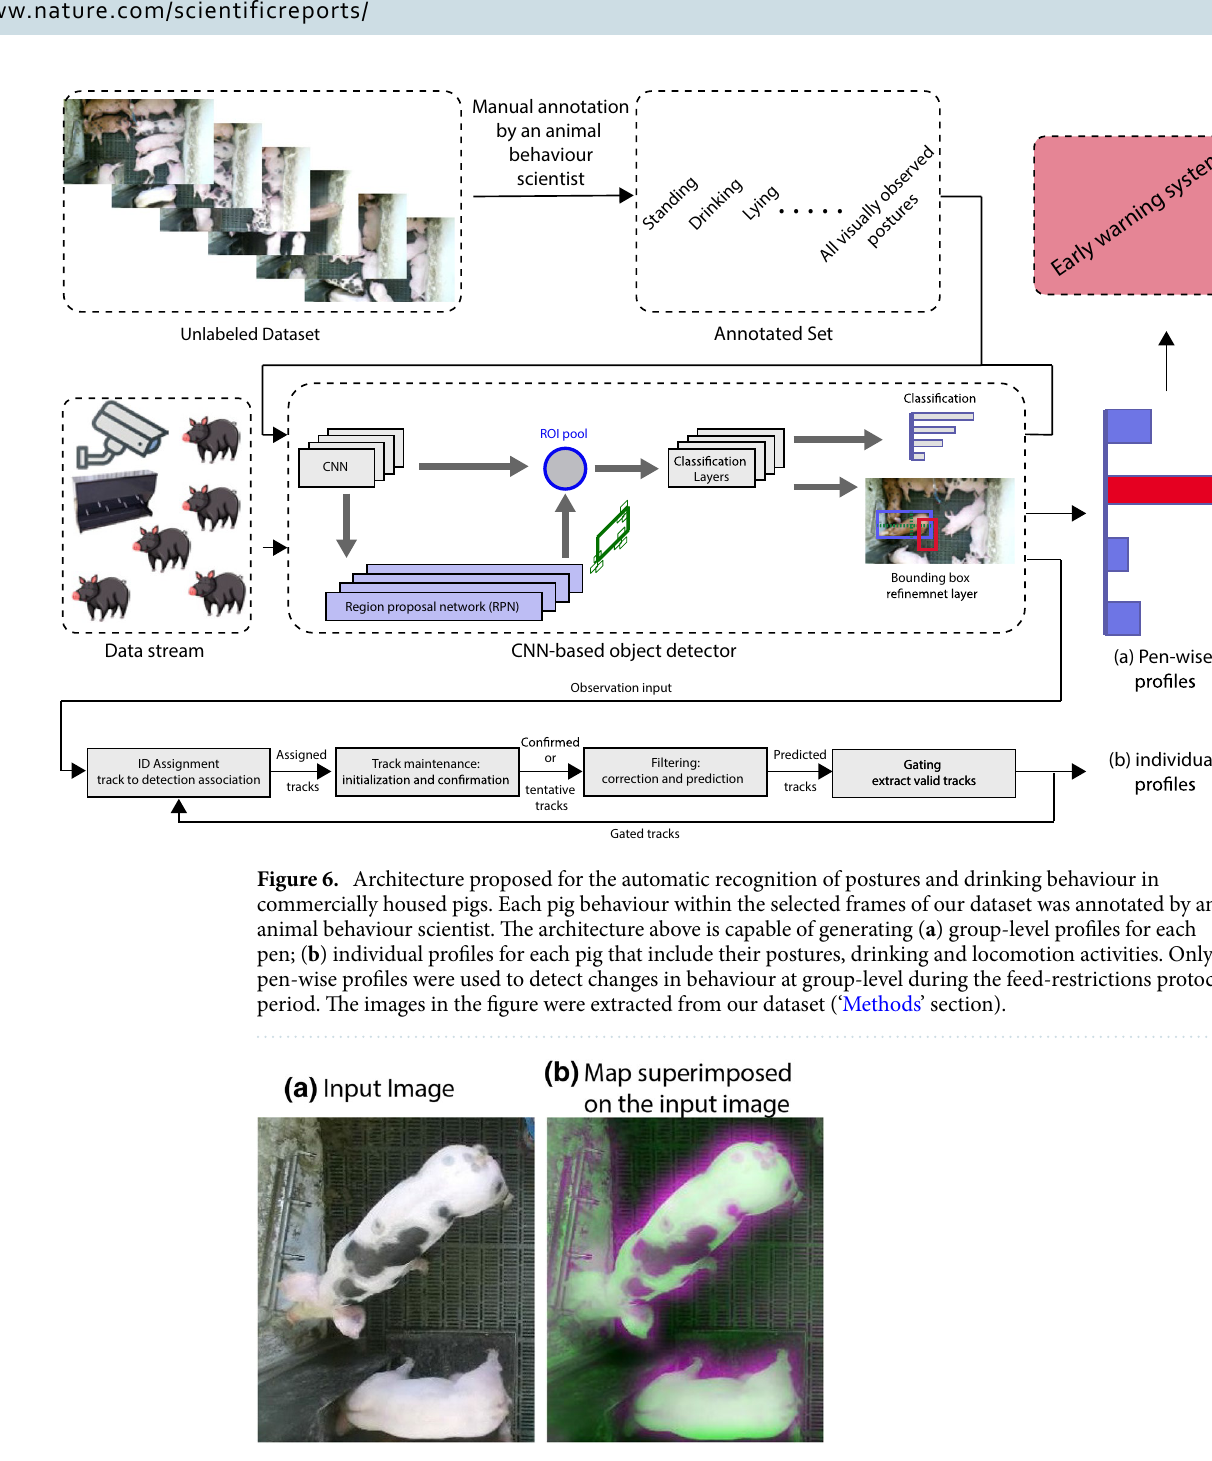
Figure 7. An example of ( a ) an input image with ( b ) the corresponding activations of the base model of the primary platform, i.e., YOLO detector with three anchor boxes. This visualisation technique highlights the areas of the image that drive the method to detect pig behaviours, standing in this specific example, showing how this model makes decisions and (potentially) identifying confounders. The images in the figure were extracted from our dataset (‘Methods’